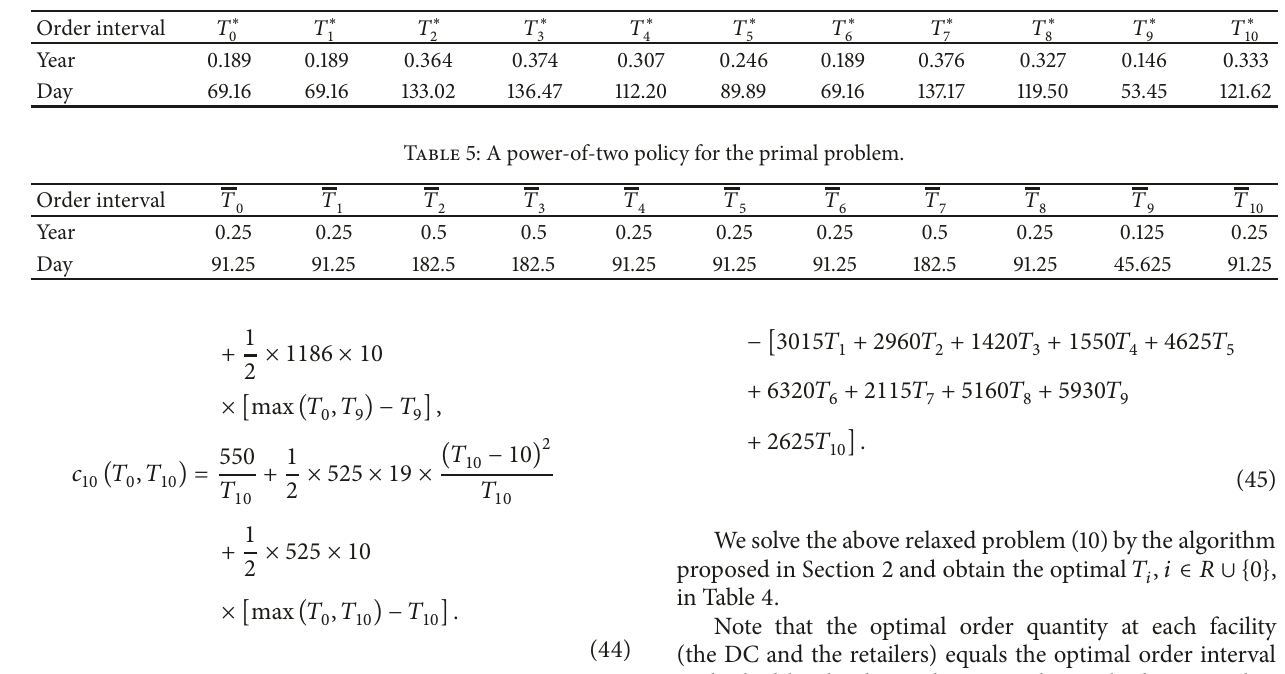
Table 4: The optimal solution for the relaxed problem.